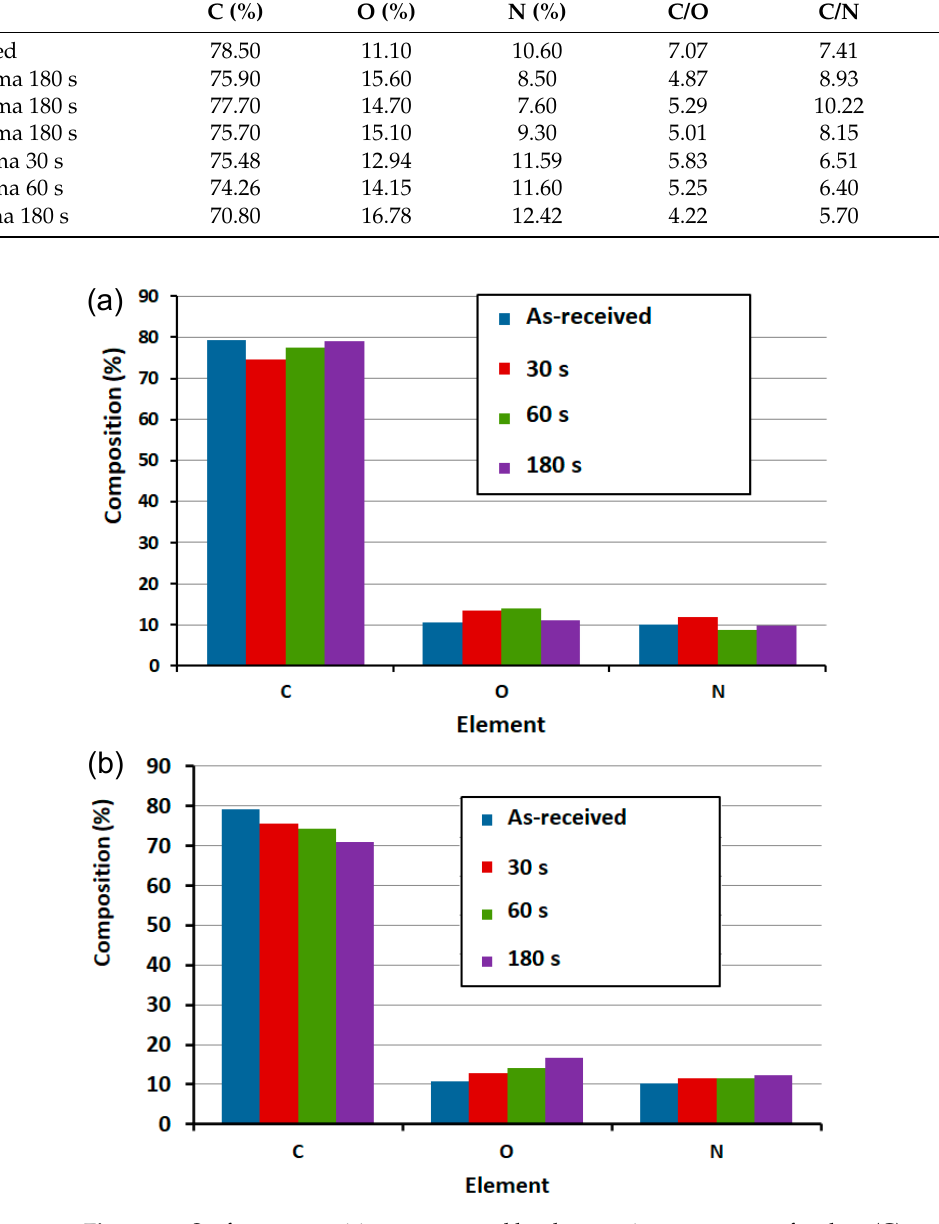
Figure 10. Surface composition represented by the atomic percentages of carbon (C), oxygen (O) and nitrogen (N) of the nylon surface after ( a ) He/5% O 2 and ( b ) He/H 2 O plasma treatment for 30, 60, and 180 s.